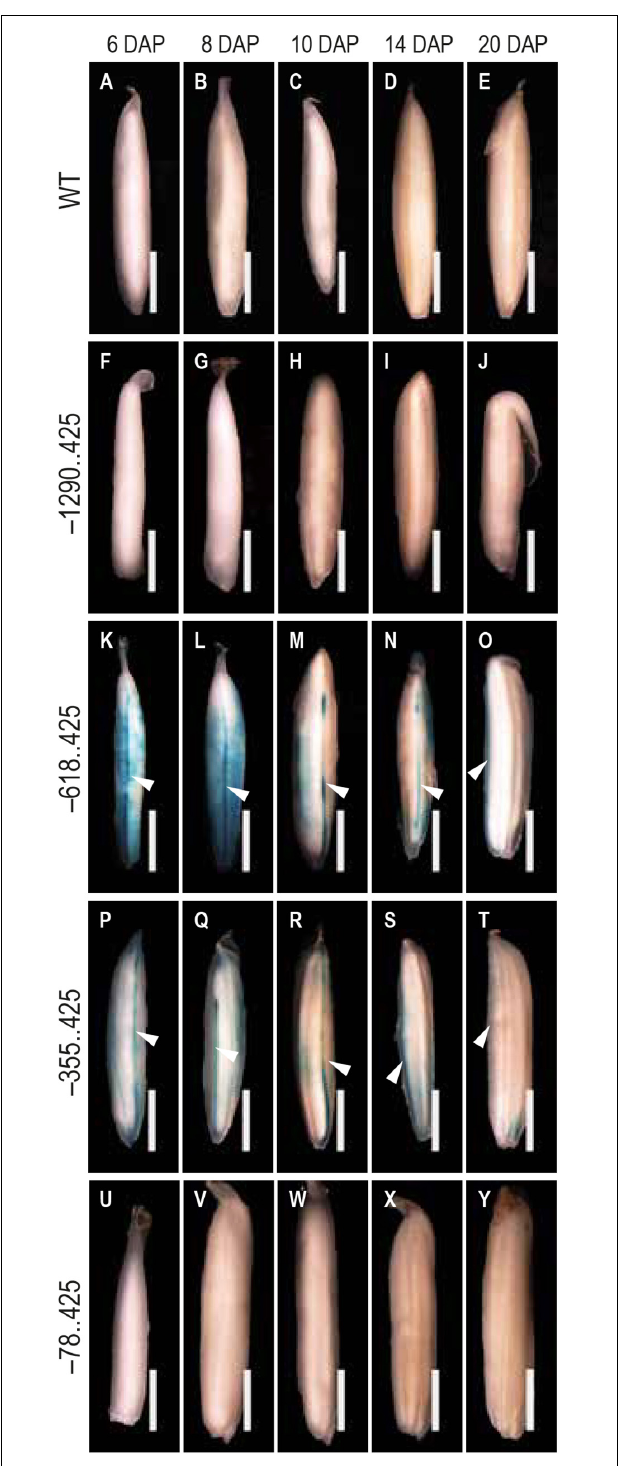
FIGURE 5 | Analysis of GUS expression pattern in the dorsal vascular trace. The panels show the GUS expression patterns in the dorsal vascular trace of 6–20 DAP seeds (A–E) WT, (F–J) –1290..425, (K–O) –618..425, (P–T) –355..425, and (U–Y) –78..425. White arrowheads in (K–T) indicate the dorsal vascular trace. Samples were photographed using a Leica Mz12.5 Stereozoom microscope. The scale bar represents 2